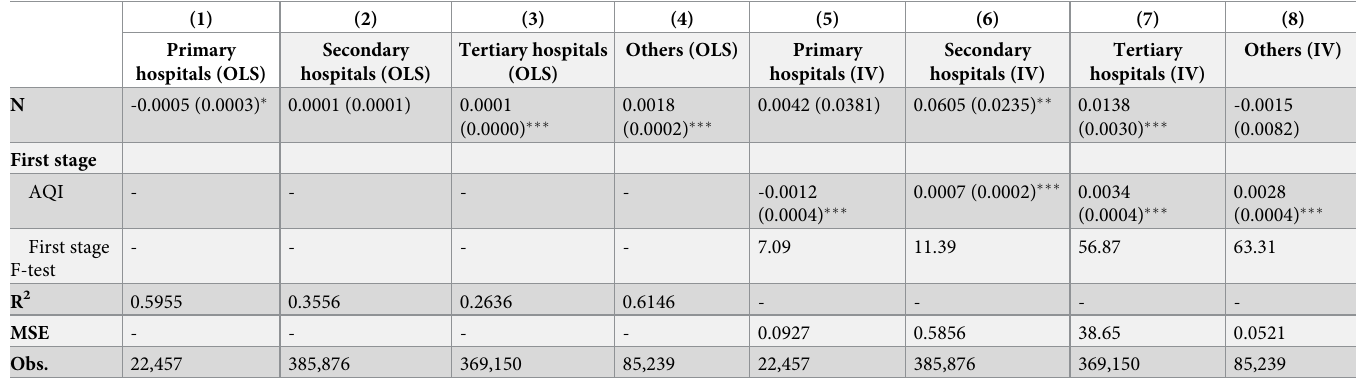
Table 6. Regression results of hospital mortality for different hospital